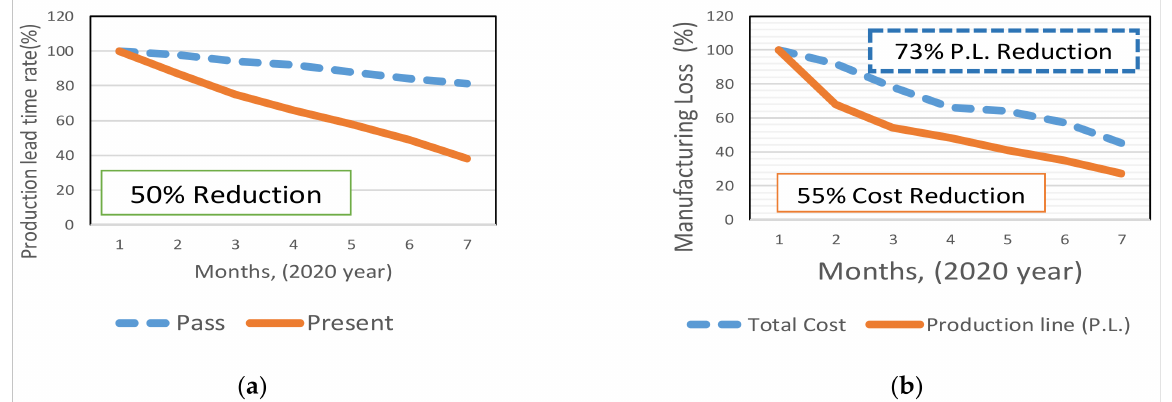
Figure 15. Statistics of benefits and results brought by the IoT in smart factories: ( a ) Product lead time, including design, production, logistics and sales process, reduced time, ( b ) product manufacturing process and assembly, its failed product components, and reduction